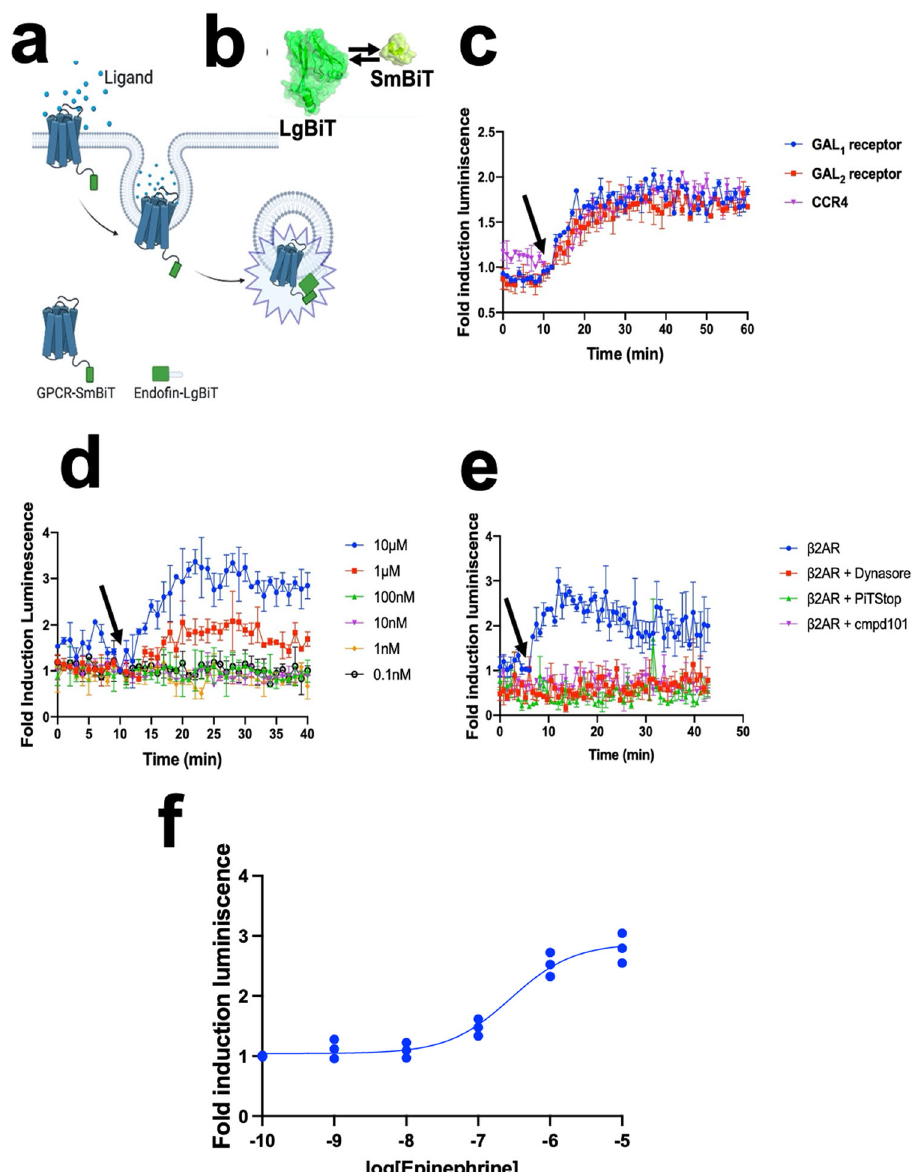
Fig. 1 GPCR internalization via early endosomes. a Schematic of the overall concept of our structural complementation assay to monitor internalization in real-time living cells. b Schematics of our structural complementation system based on Nano Luciferase showing the LgBiT (Large fragment of Nano Luciferase) and SmBiT (Small fragment of Nano Luciferase). c Different internalization rates across different GPCRs. Galanin receptors were stimulated using 10 µ M Galanin (GAL 1 and GAL 2 receptors) whereas, in the case of chemokine receptor 4 (CCR4), 100 ng/ml of SDF-1 α was used. d Dose-dependent internalization of human β 2AR in early endosomes in cardiomyocytes using different concentrations of epinephrine. e Validation of the GPCR internalization assay using 10 µ M of endocytosis inhibitors, cmpd101, PiTStop, and Dynasore. f Dose-response curve stimulation for internalization of β 2AR. The results are expressed as mean ± s.e.m. of three experiments performed in triplicate; each triplicate was averaged before calculating the s.e.m. The corresponding Z ’ factor was